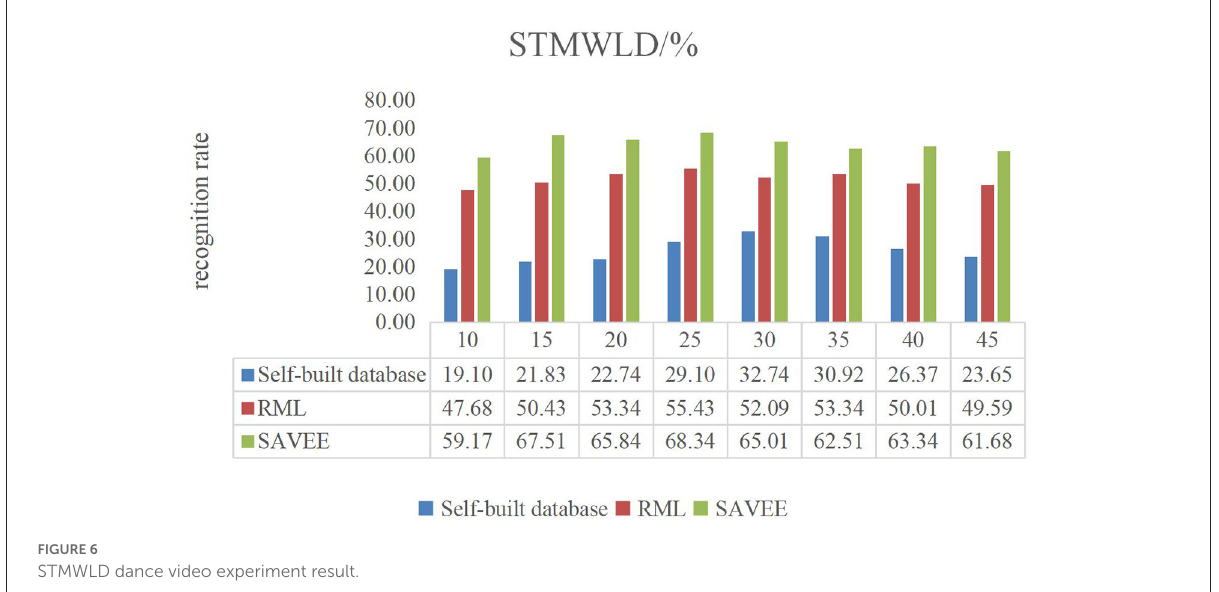
FIGURE6 STMWLD dance video experiment result.